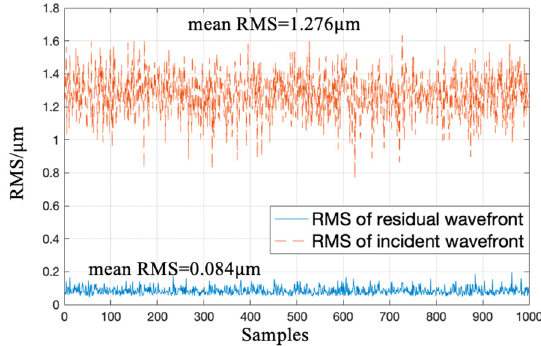
Figure 8. Wavefront reconstruction accuracy of samples in the test set.